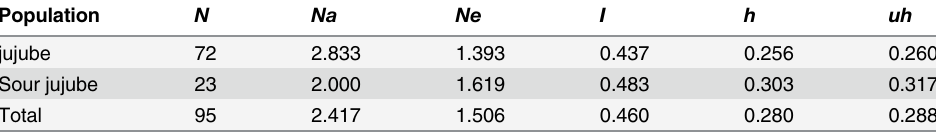
Table 3. Genetic diversity indices of the populations of wild jujube and